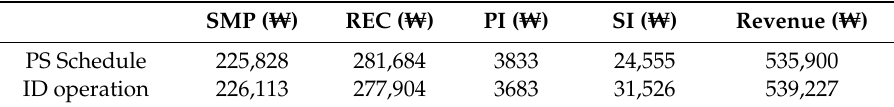
Table 3. Revenue of PS schedule and ID operation.